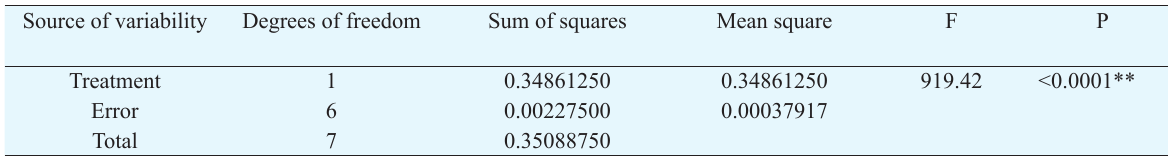
(Table 5). T . harzianum biocontrol strain T-22 inhibited the growth of C. cassiicola mycelia by 41.8% compared with 0.0% for the control. ANOVA indicated that there was a significant difference between treatments, with a coefficient of variability of 9.32% ( Table 6), and Tukey’s multiple comparison test showed that T . harzianum strain T-22 significantly inhibited the growth of C. cassiicola compared with the control at the 0.05 level (Table 7).